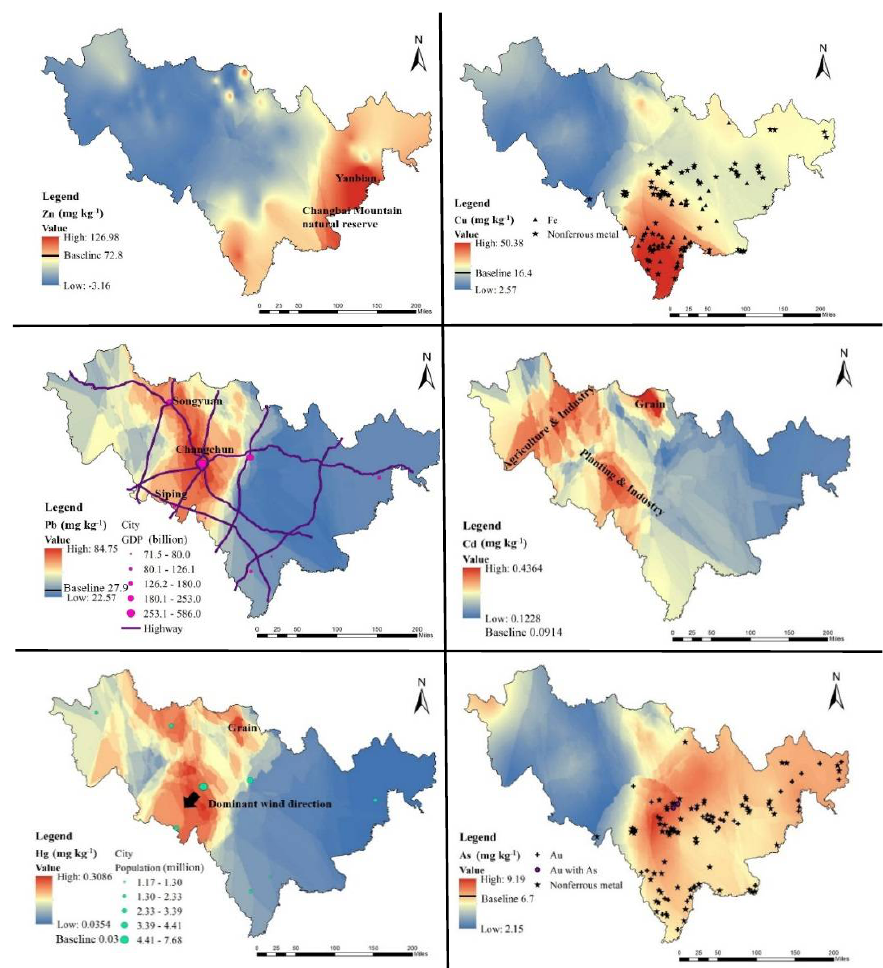
Figure 2. Distribution of six toxic elements in Jilin Province farmland.